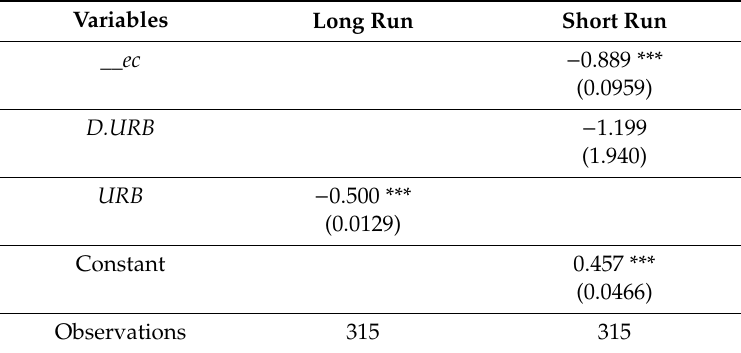
Table 7. Results of PMG